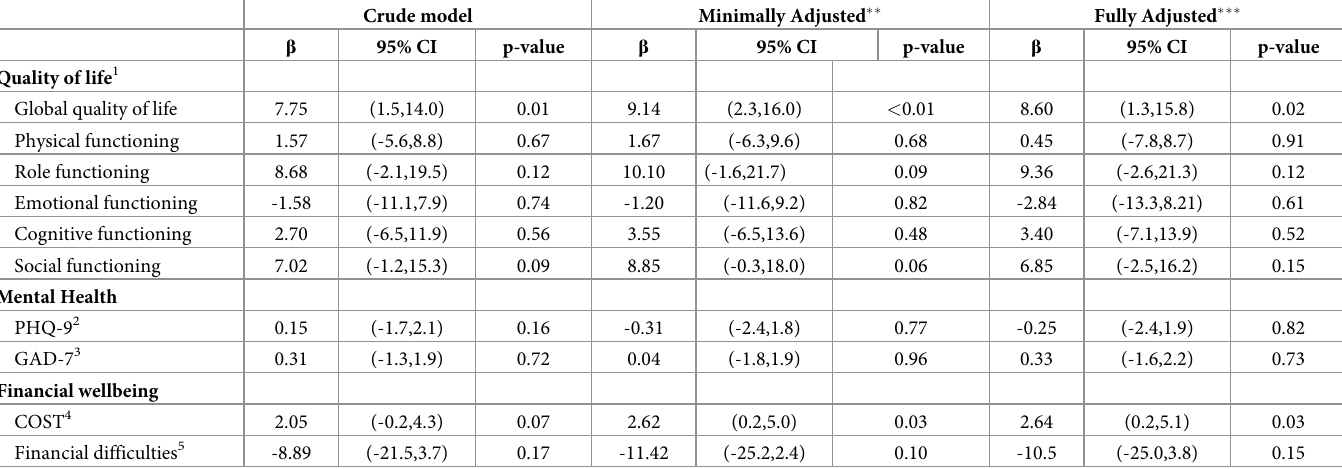
Table 4. A multivariate linear regression analysis for crude and adjusted beta coefficients for the independent association between receipt of facilitated access to care and patients’ self-reported outcomes.